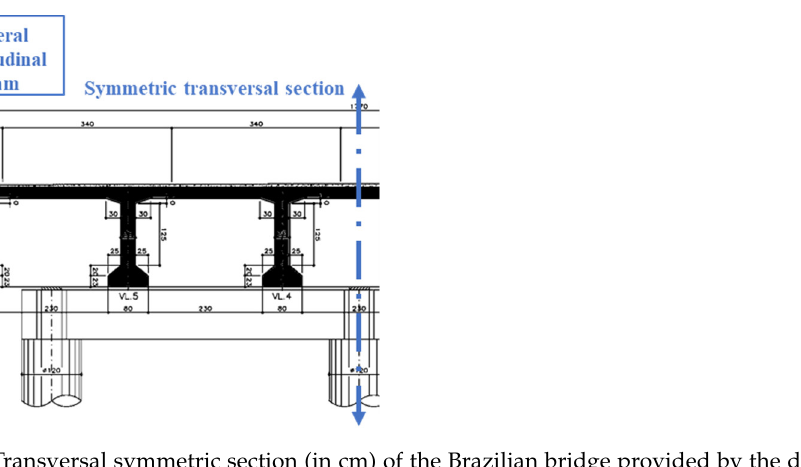
Figure 2. Transversal symmetric section (in cm) of the Brazilian bridge provided by the designer (VL = Longitudinal beam) [59,62].